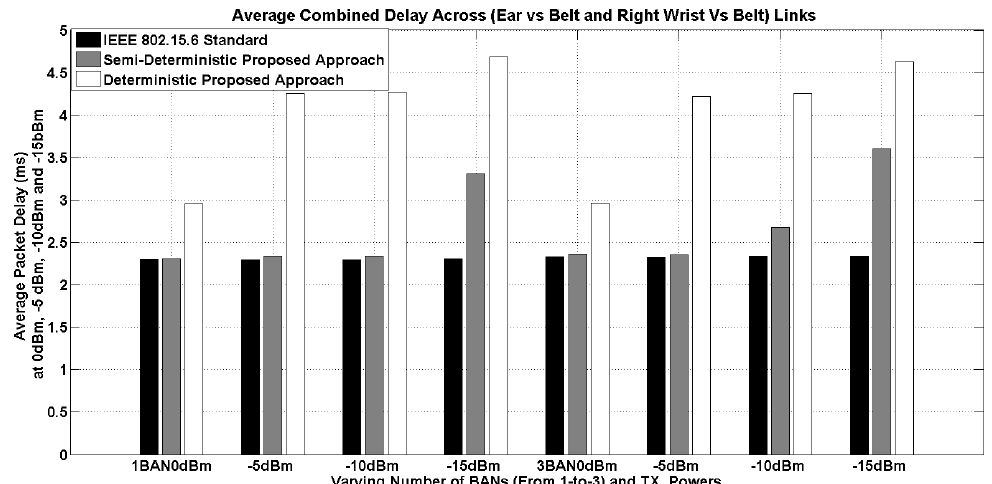
Figure 14. Average end-to-end packet delay at varying transmission power for one and three BANs (having three nodes per BAN).